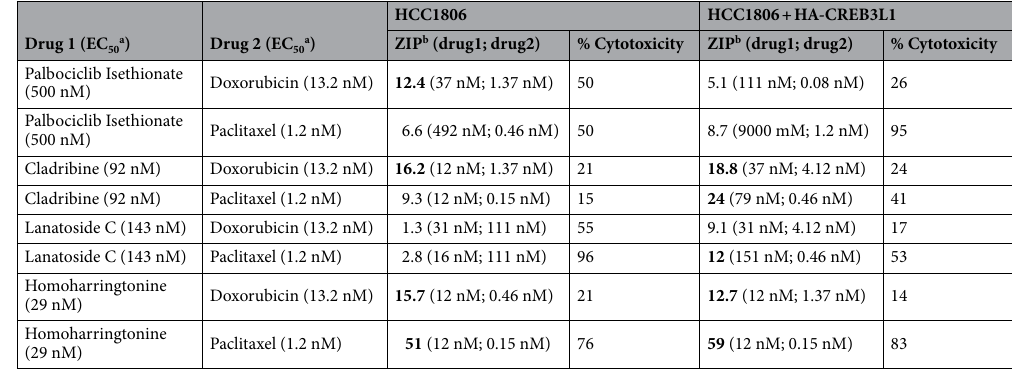
Table 3. Synergy of drug combinations. Significant values are in [bold]. a EC 50 as single agent in HCC1806 cells. b ZIP, zero-interaction potency; scores > 10 indicate